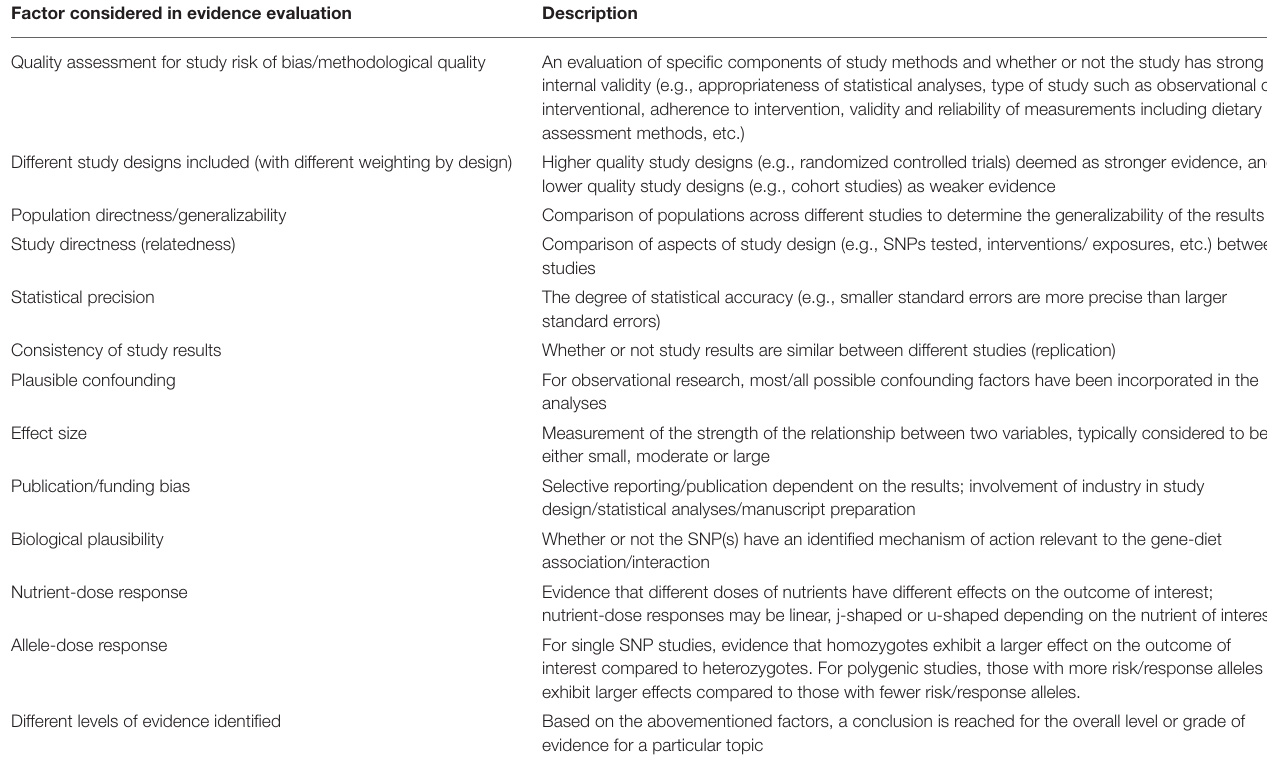
TABLE 1 | Description of factors deemed important to consider for evaluating the body of evidence in nutritional